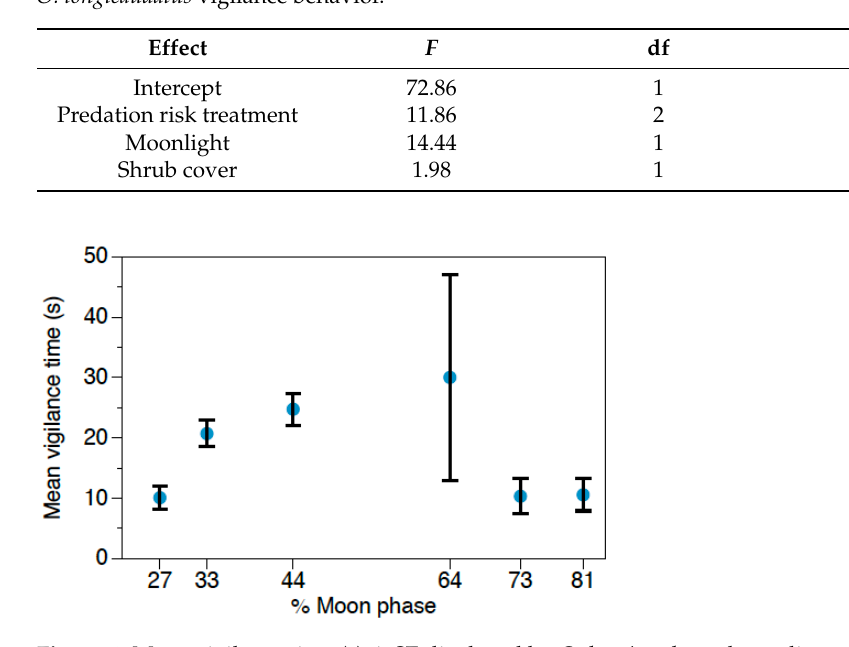
Figure 4. Mean vigilance time (s) ± SE displayed by O. longicaudatus depending on moonlight.